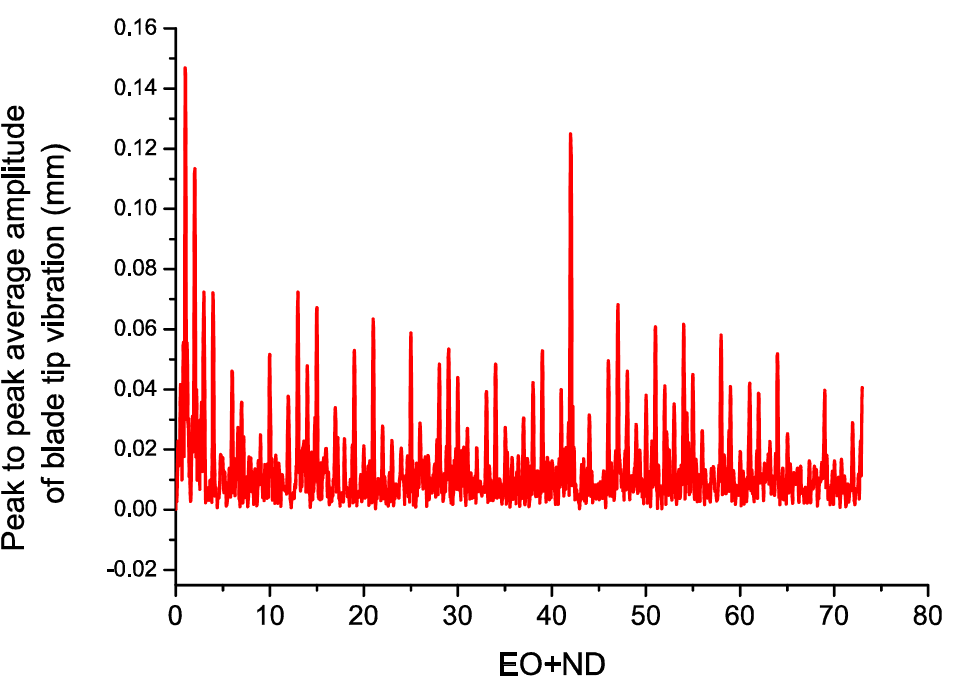
Figure 9. Travelling wave frequency spectrum of the